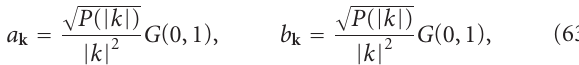
with SF: α = − 1 / 2 and λ = 5 Mpc /h . The curve that is just below the continuous line (dotted line) is